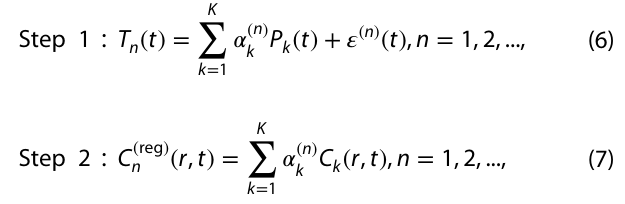
Fig. 2 Month of a maximum BLH_ , b minimum BLH_ , c maxi- max max mum BLH_ , and d minimum BLH_ . The red colors represent min min warm months and the blue colors cold months. The numbers on the map denote the months of the respective